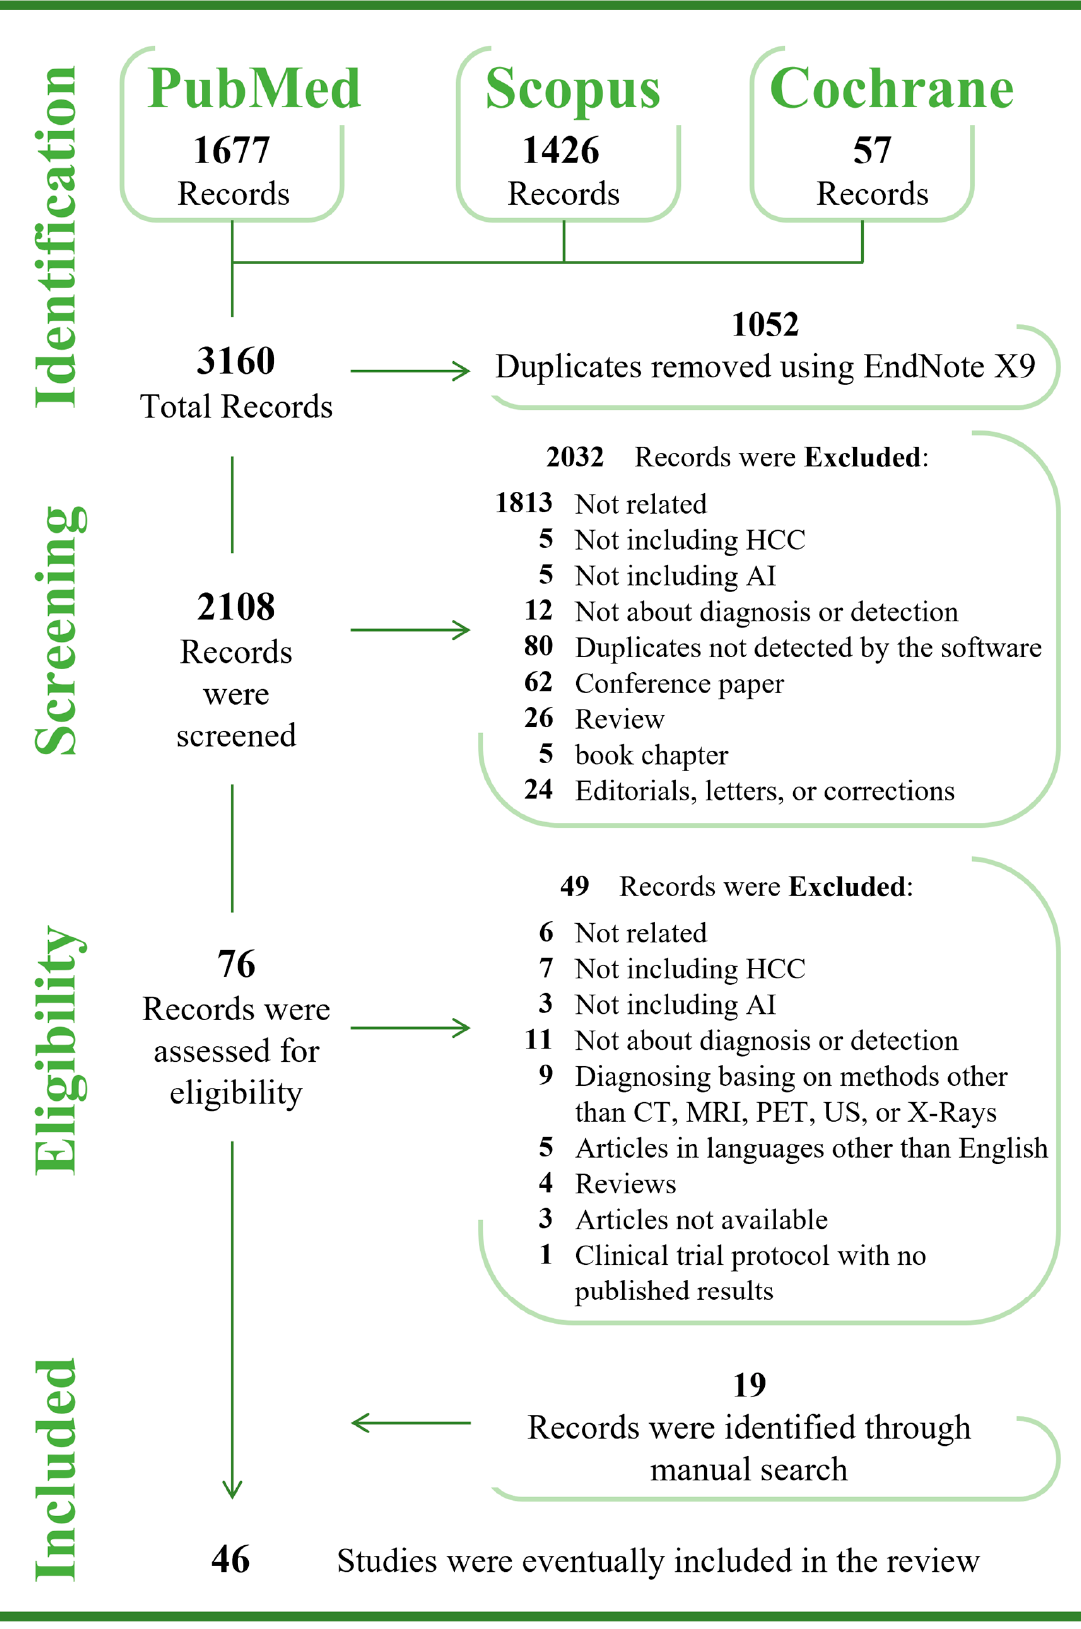
Figure 1. PRISMA Flow Diagram.